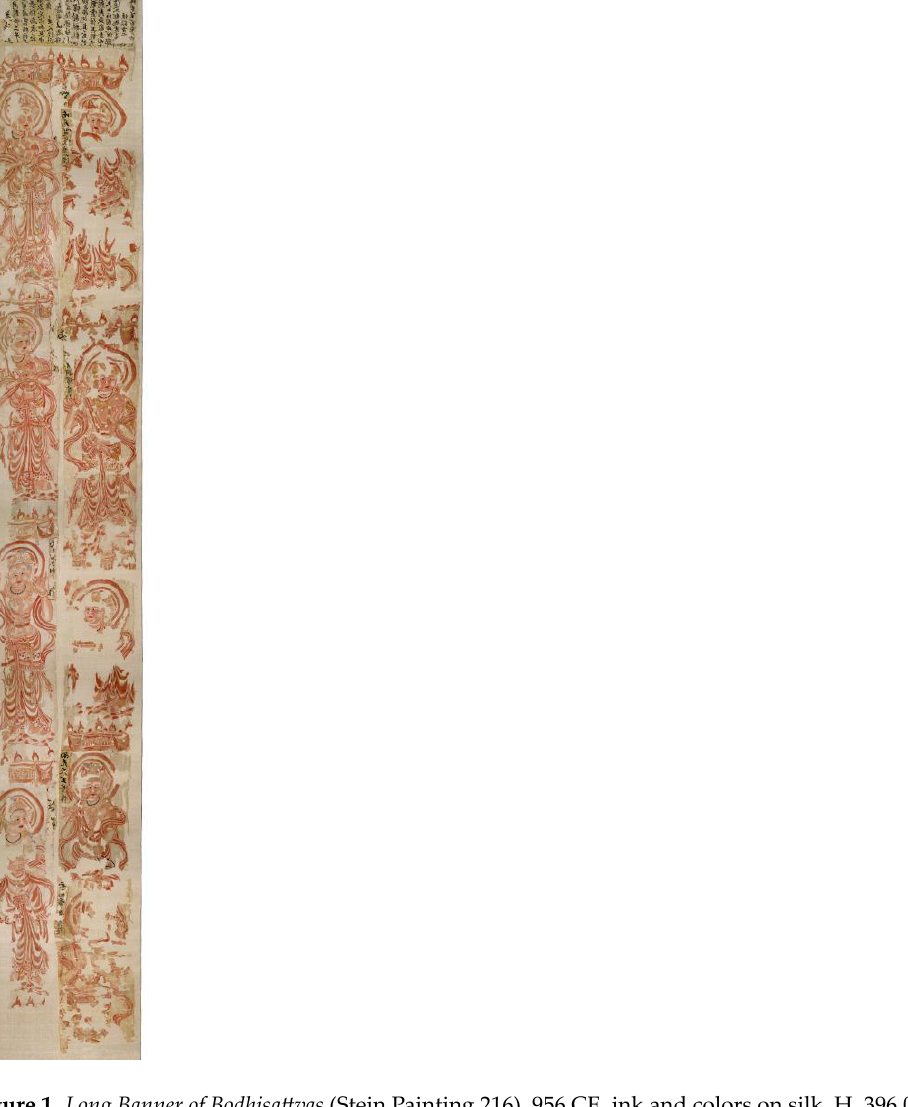
of color; the buddha or bodhisattva figures are drawn with lines that are not fully filled in with color. Where color is used, the shading scheme is simple and features red, yellow, thickness. Each figure is delineated with bold lines and the painting style is not